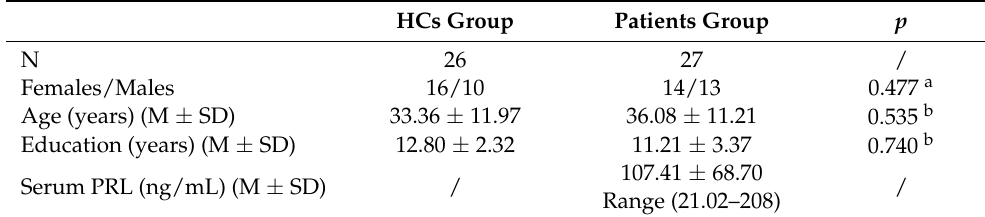
Table 1. Summary of the participants’